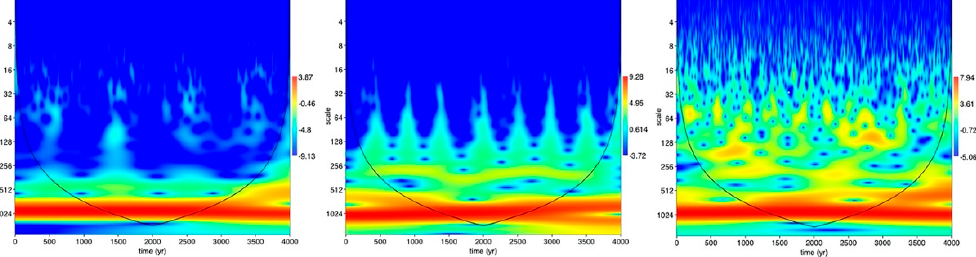
Figure 6. WT scalograms for the fixed value of a = 0.46 and different noise amplitude values, i.e., α = 0.05 (left side), 0.23 (center), and 0.70 (right side).